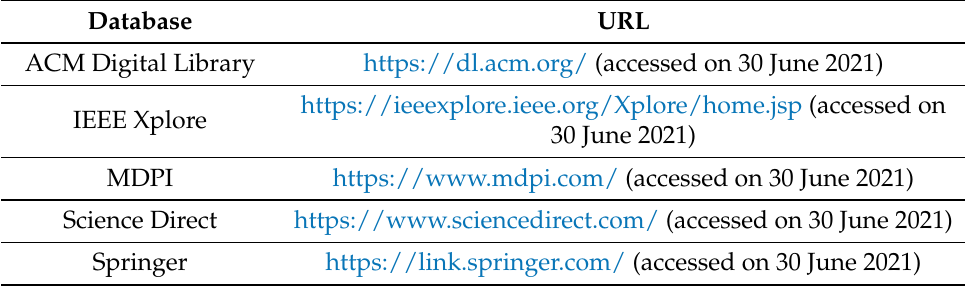
Table 3. Databases used in the search